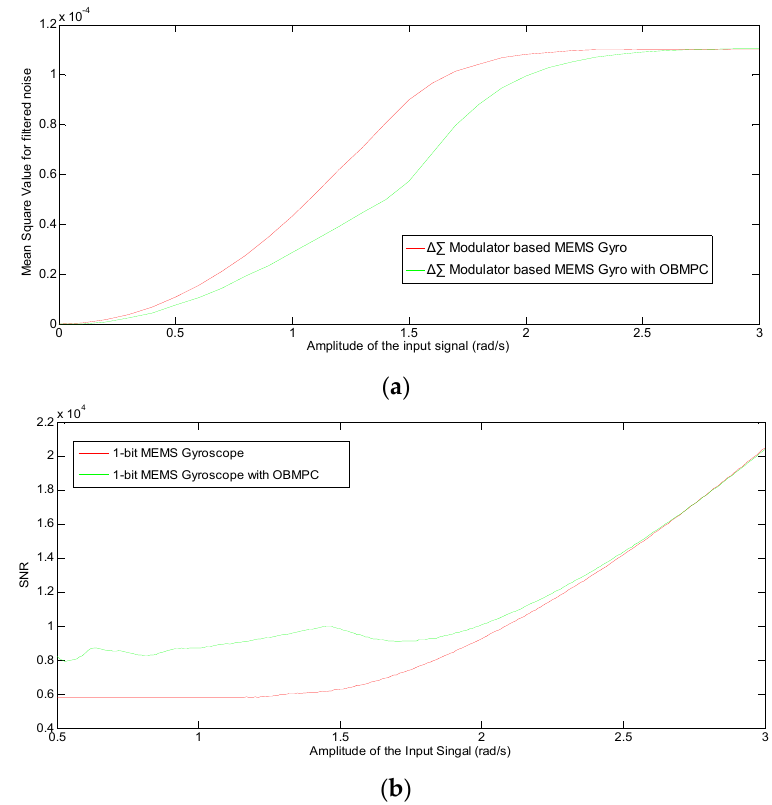
Figure 14. ( a ) MSE and ( b ) SNR of the quantization noise with different input amplitude.